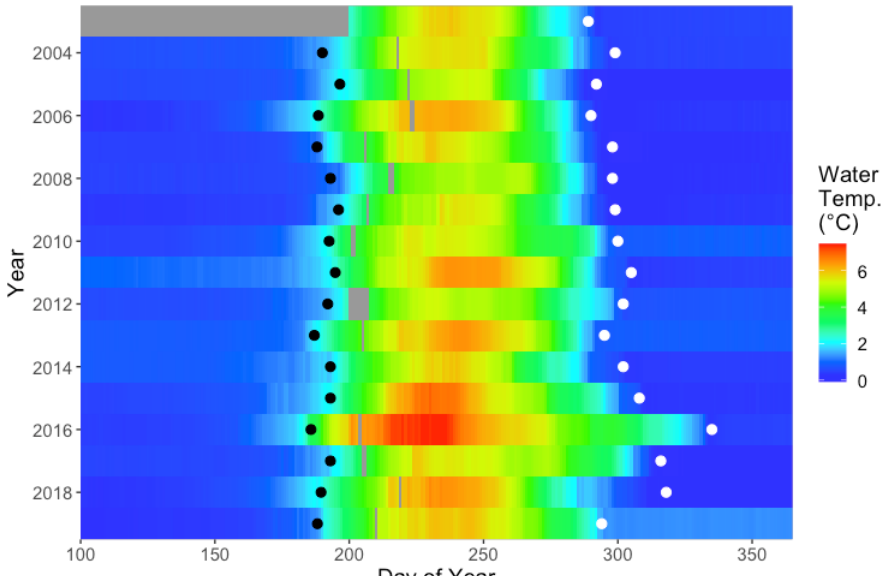
Figure 7. Daily mean water column temperature for mooring G in Linnévatnet as a function of year (y-axis) and day-of-year (x-axis). Blue indicates colder temperatures, while red indicates warmer temperatures. Gray indicates missing data. Estimates of BUE and FUE dates are shown for each year (black and white dots, respectively), based on lake water temperature dynamics.